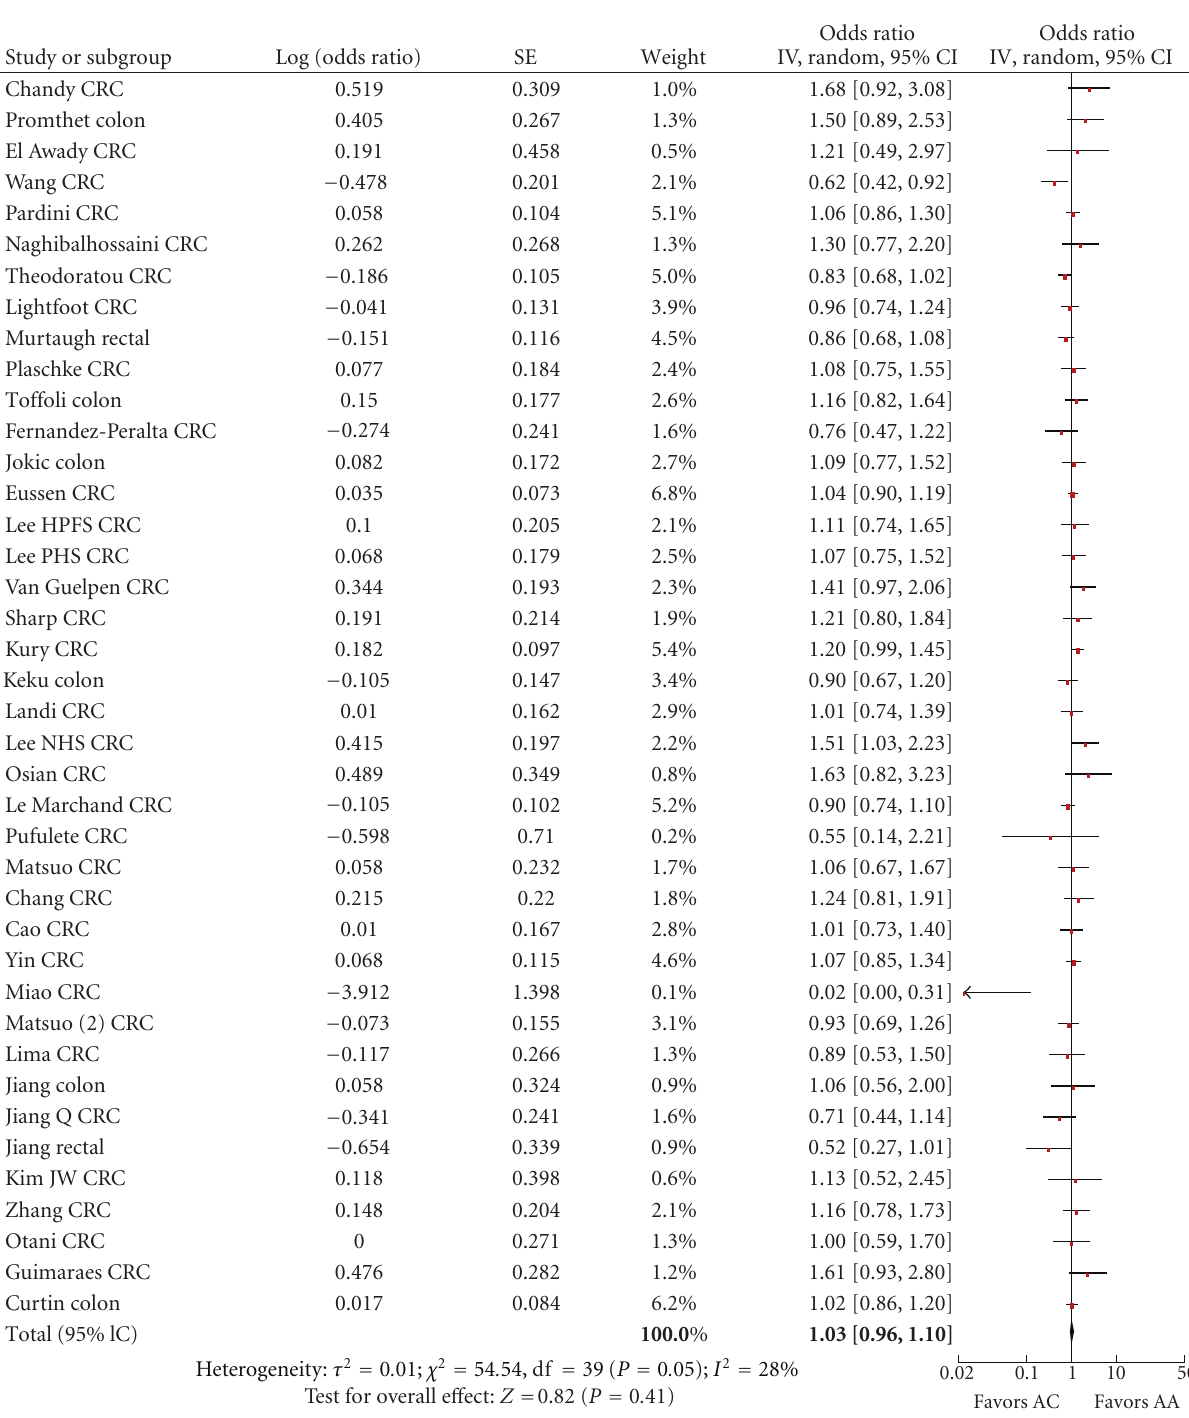
Figure 4: Forest plot of the risk of colorectal cancer for MTHFR 1298 AC versus